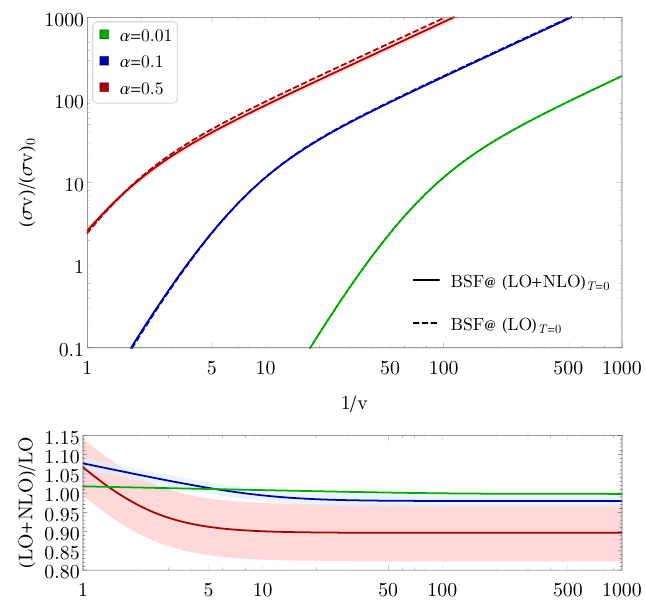
Figure 12 . Upper panel: BSF cross section normalized to the tree-level annihilation cross section at LO (dashed lines) and NLO (solid lines) in dependence of the inverse relative velocity for di(cid:11)erent coupling strengths (cid:11) while (cid:12)xing the renormalization scale to (cid:22) 0 = E 100 = m (cid:31) (cid:11) 2 = 4 (assuming N = 1). Shaded areas (barely visible) indicate the scale uncertainty by varying the renormalization scale between (cid:22) 0 = 2 E 100 and (cid:22) 0 = E 100 = 2. Lower panel: relative correction of the NLO contribution with respect to the LO cross section with the renormalization scale (cid:12)xed at (cid:22) 0 = E 100 = m (cid:31) (cid:11) 2 = 4 (solid lines). The shaded area indicates the renormalization uncertainty as in the upper